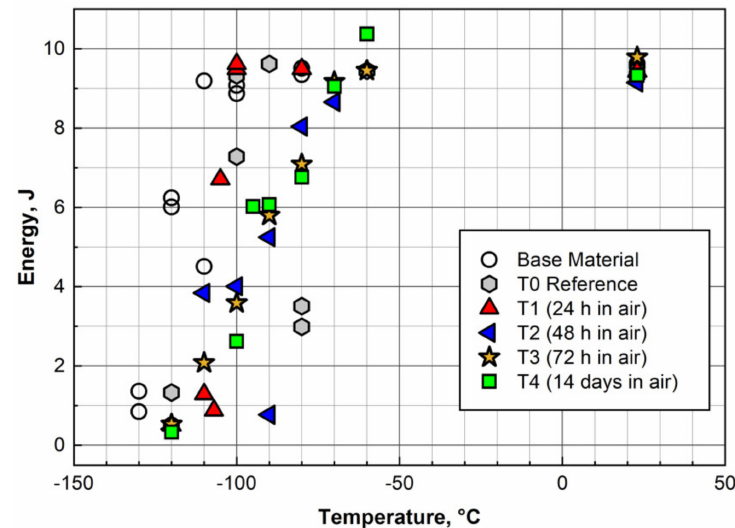
Figure 28. Charpy test results of the samples with different oxidation periods prior to diffusion bonding at 25 MPa, 1150 ◦ C for 2 h and after post-weld heat treatment of 980 ◦ C/0.5 h + 760 ◦ C/2 h. Oxidation times at 70% relative humidity: 0 h (T0), 1 day (T1), 2 days (T2), 3 days (T3), 14 days (T4). The circles represent results with the base material (EUROFER97/2, heat 993402).